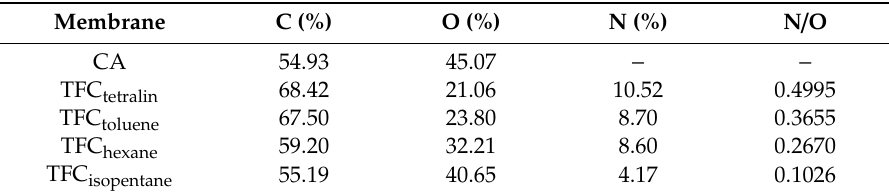
Table 1. Atomic composition and N / O ratio of the membranes from XPS analysis.